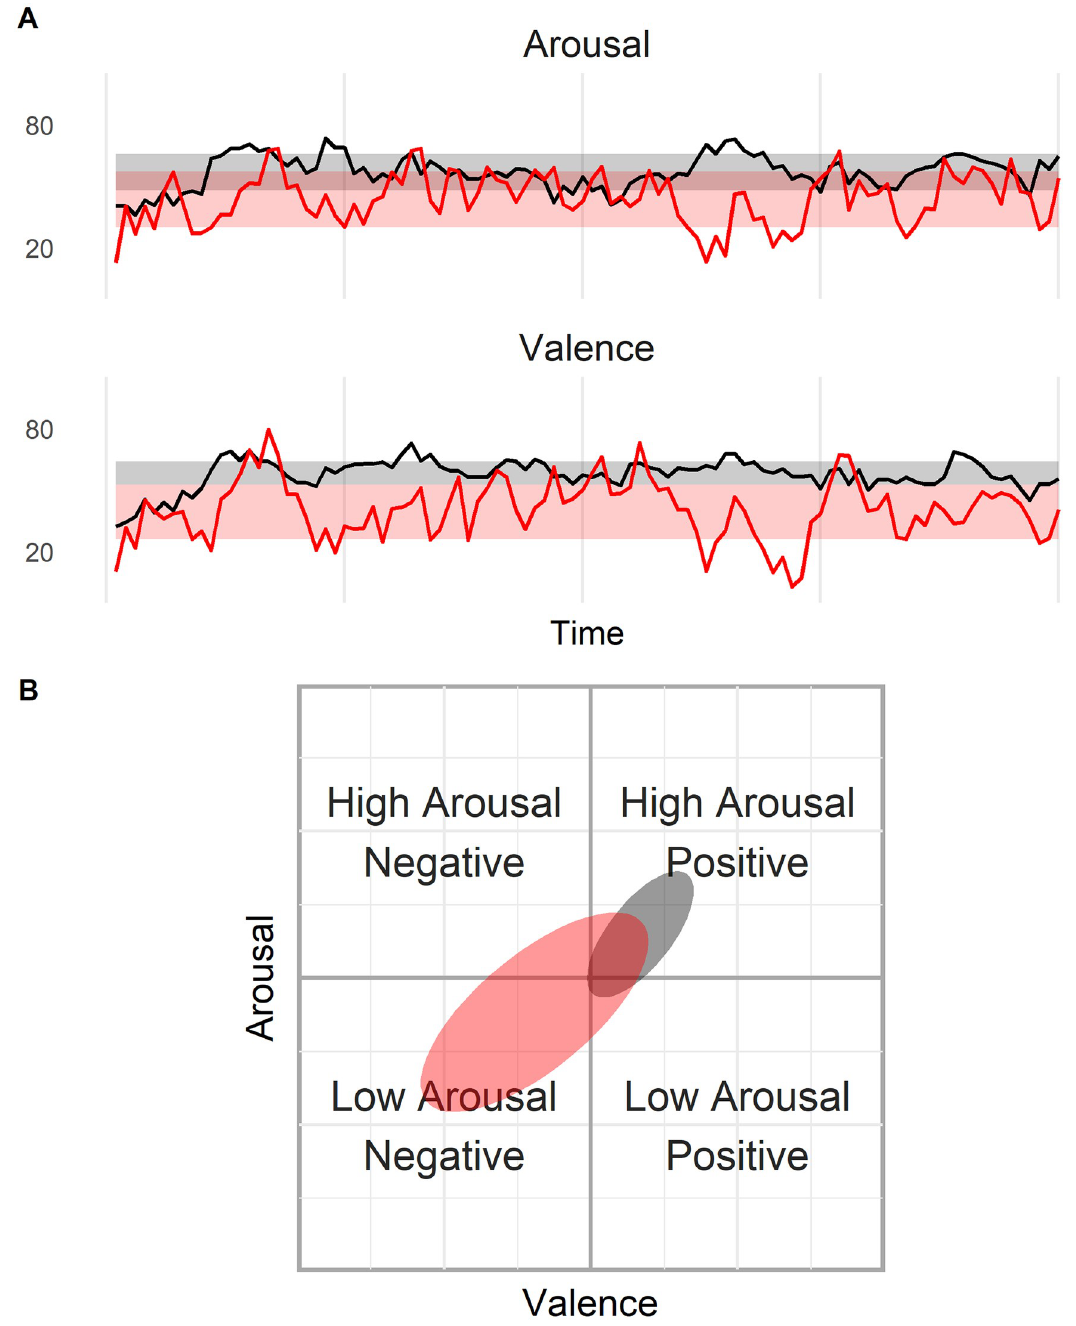
Fig 1. Panel A (one dimensional) : Two hypothetical (simulated) emotion trajectories —separately for valence (v) and arousal (a). Shaded bands are the home bases. Panel B (two dimensional) : Home bases of two hypothetical trajectories in v–a